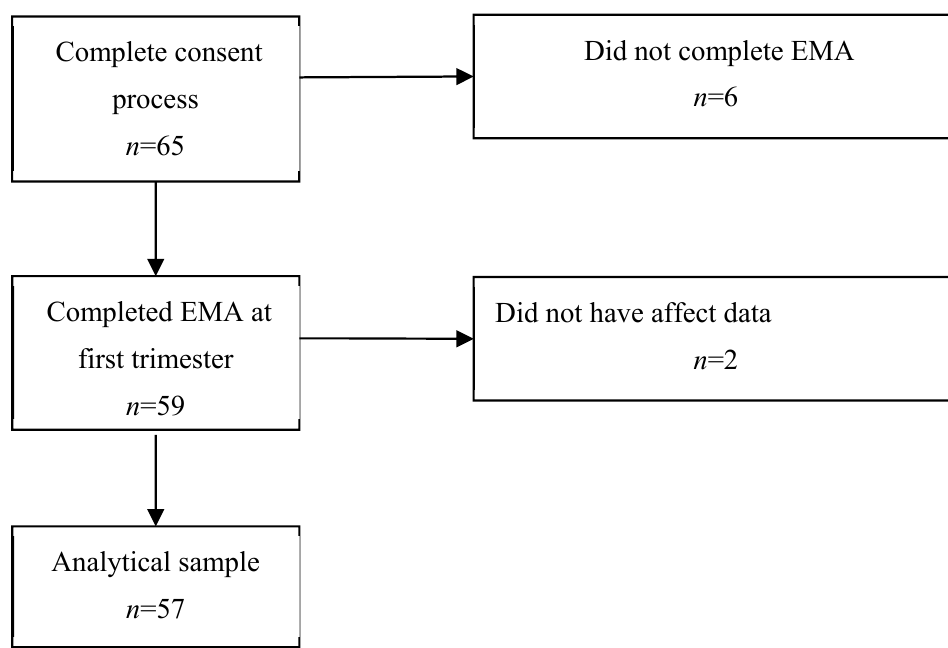
Figure 1. Diagram of flow of study participants.